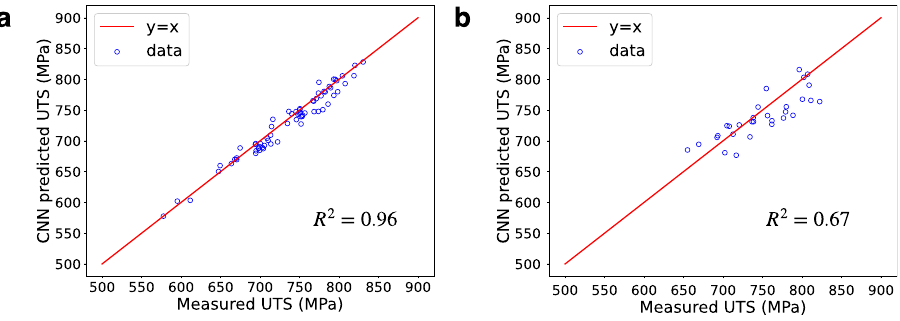
Fig. 8 Measured UTS versus predicted UTS. a Training data. b Test